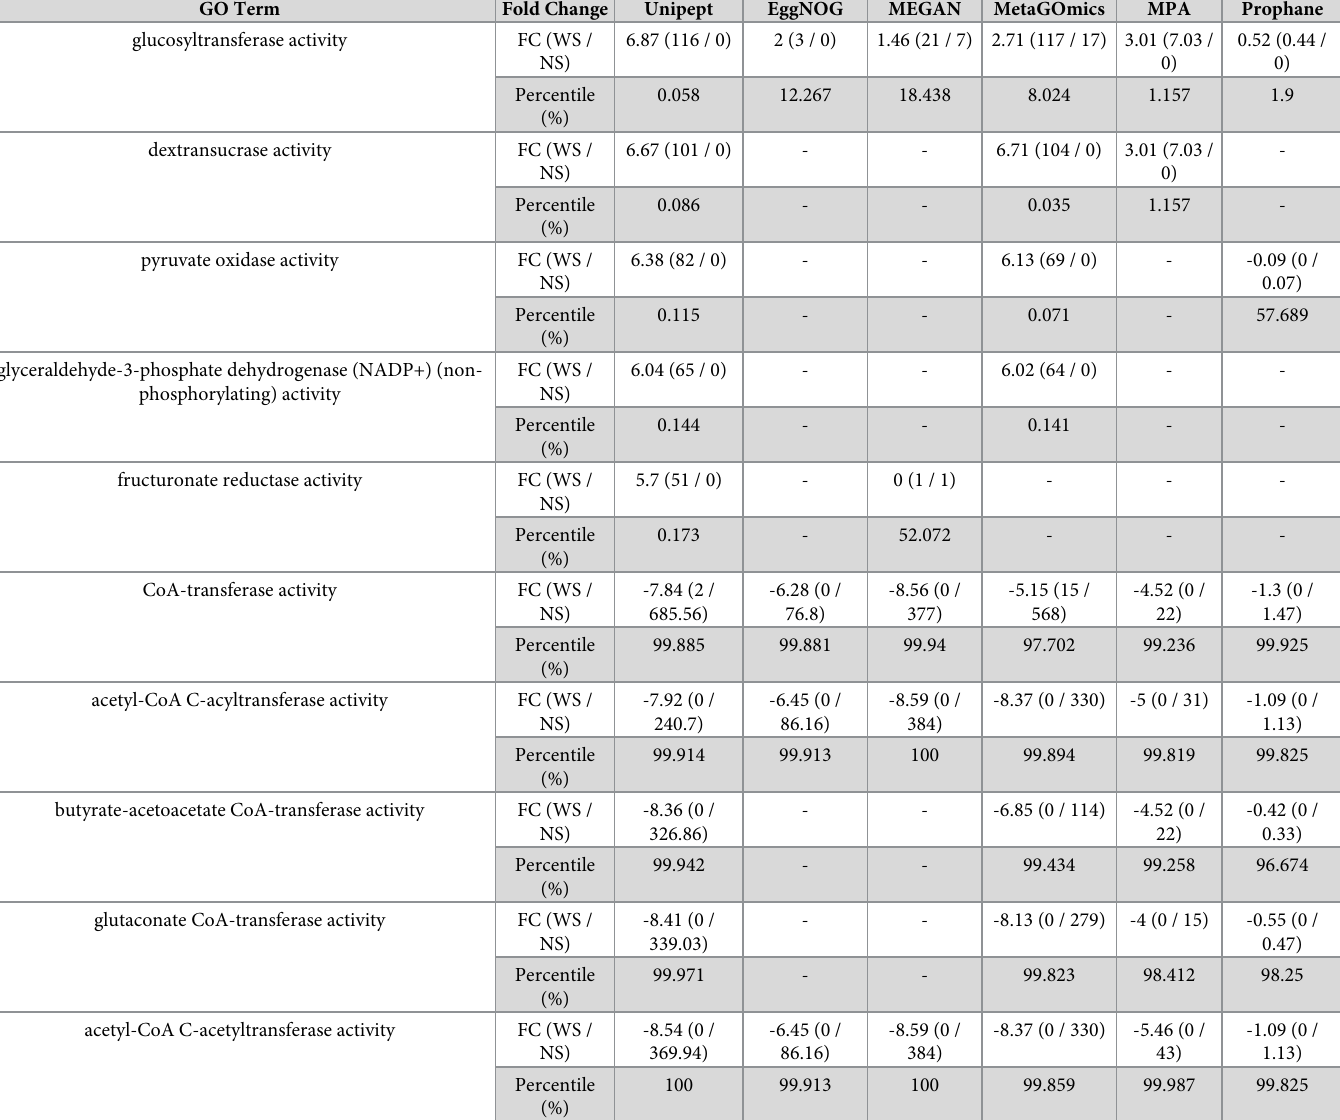
Table 2. Comparison of the top five upregulated and top five downregulated molecular function GO terms of Unipept with the molecular function GO terms from the other tools from the oral dysbiosis